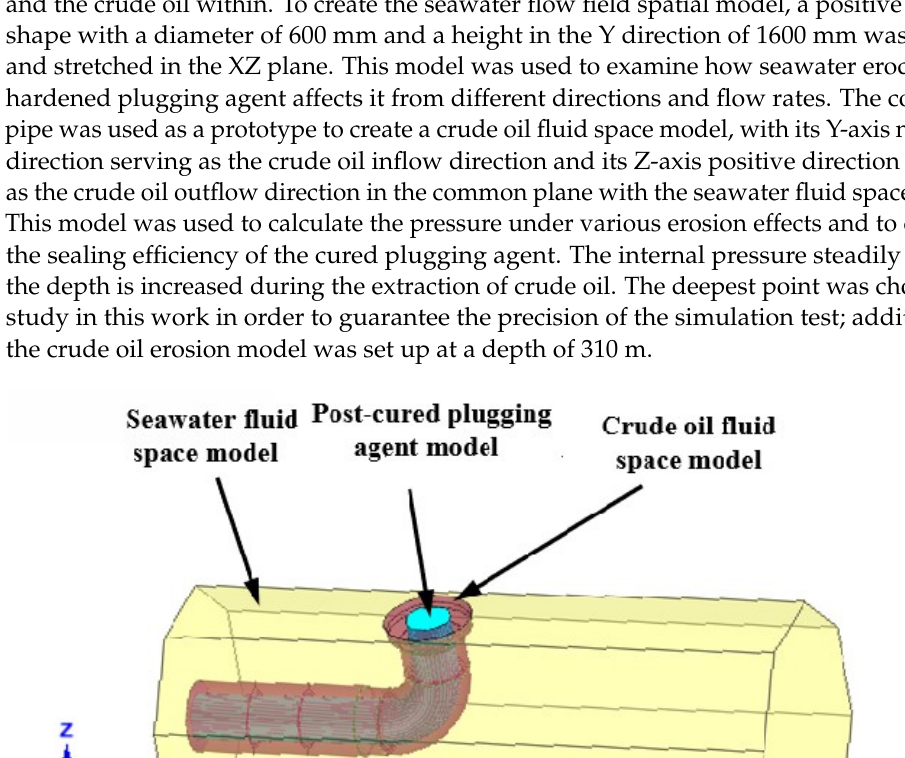
Figure 4. Seawater and petroleum oil fl ow fi eld spatial model.